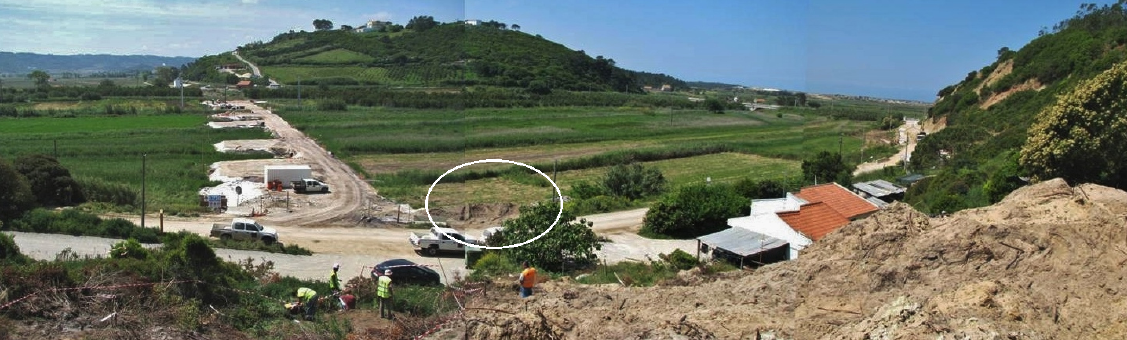
Figura 2. Vista dos trabalhos no Meu Jardim, com a Lagoa da Pederneira no lado esquerdo da imagem. O círculo branco indica a área das sondagens arqueológicas. Figure 2. Overview of the works at Meu Jardim, with the Pederneira Lagoon on the left of the photo. White circle indicates the archaeological intervention